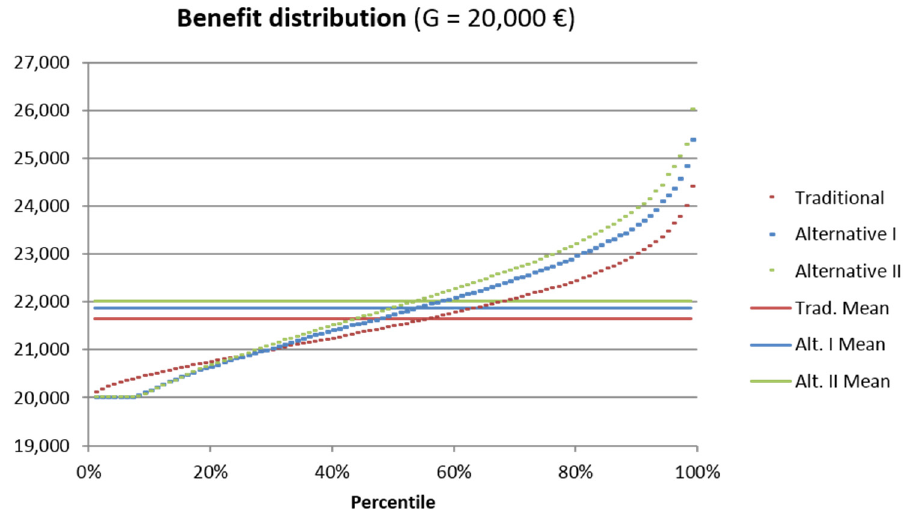
Figure 5. Benefit distribution of products with the same PVFP and reduced SCR mkt , based on the